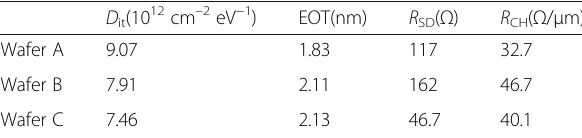
Table 1 Calculated properties of Ge pMOSFETs in three passivation conditions